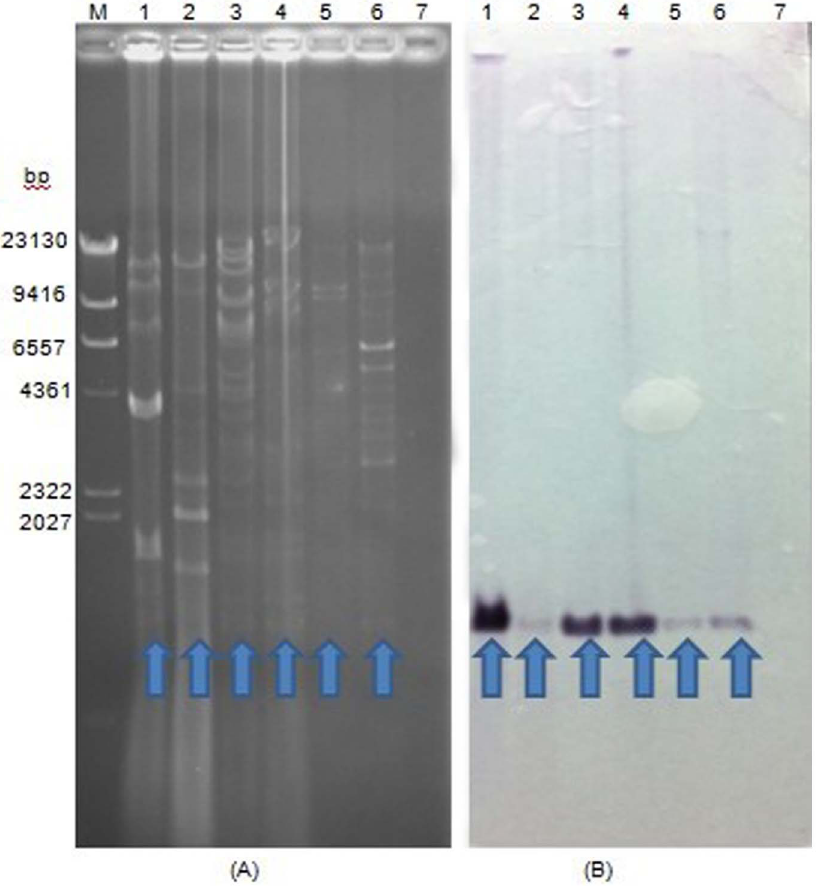
Figure 3. EcoRI-digestion profiles and Southern blotting results of extracted plasmids. (A) Plasmid digested with EcoRI and then run in gel. (B) Southern blot hybridization results of digested plasmid DNA. M: l DNA\HindIII. Lane 1 , 7: K. pneumoniae M194, Enterobacter cloacae Q297, Enterobacter aerogenes Q442, Citrobacter freundii X122, A. calcoaceticus G113, A. calcoaceticus X231 and K. pneumoniae U091,